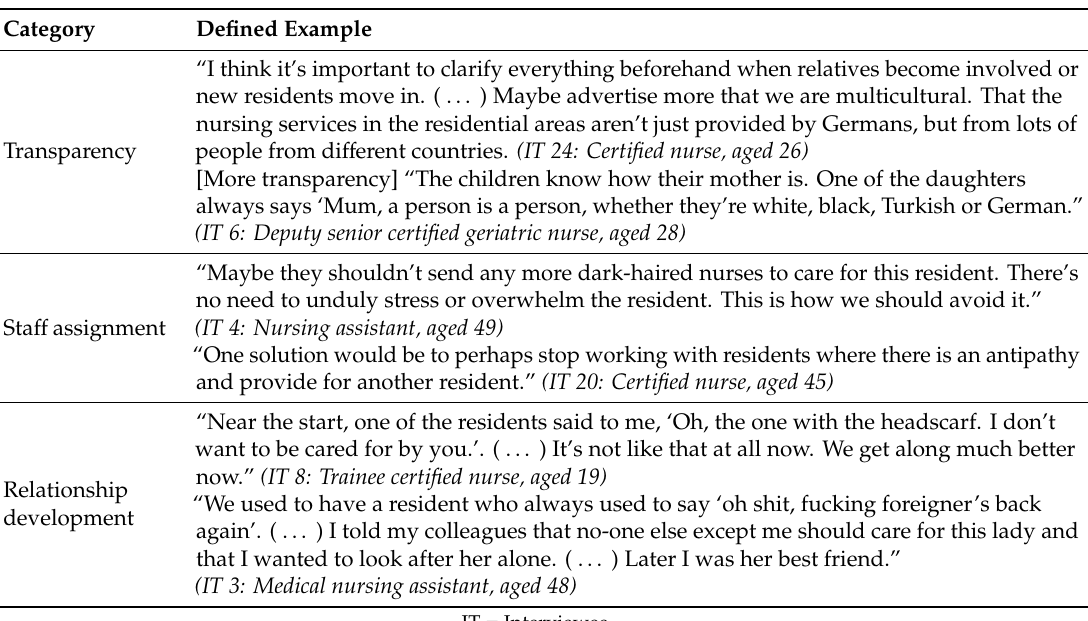
Table 5. Recommendations for institutions for avoiding / reducing